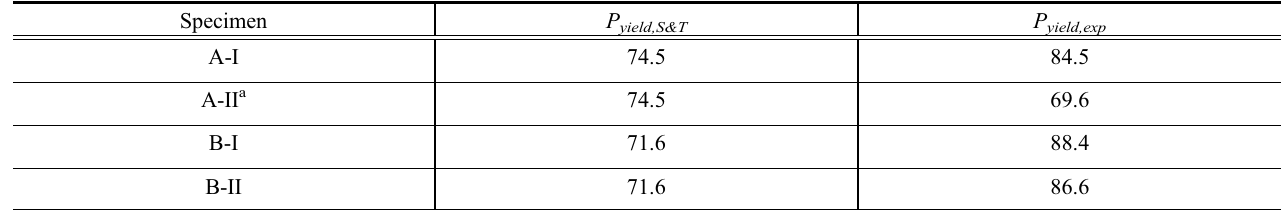
Table 1 Summary of test results.